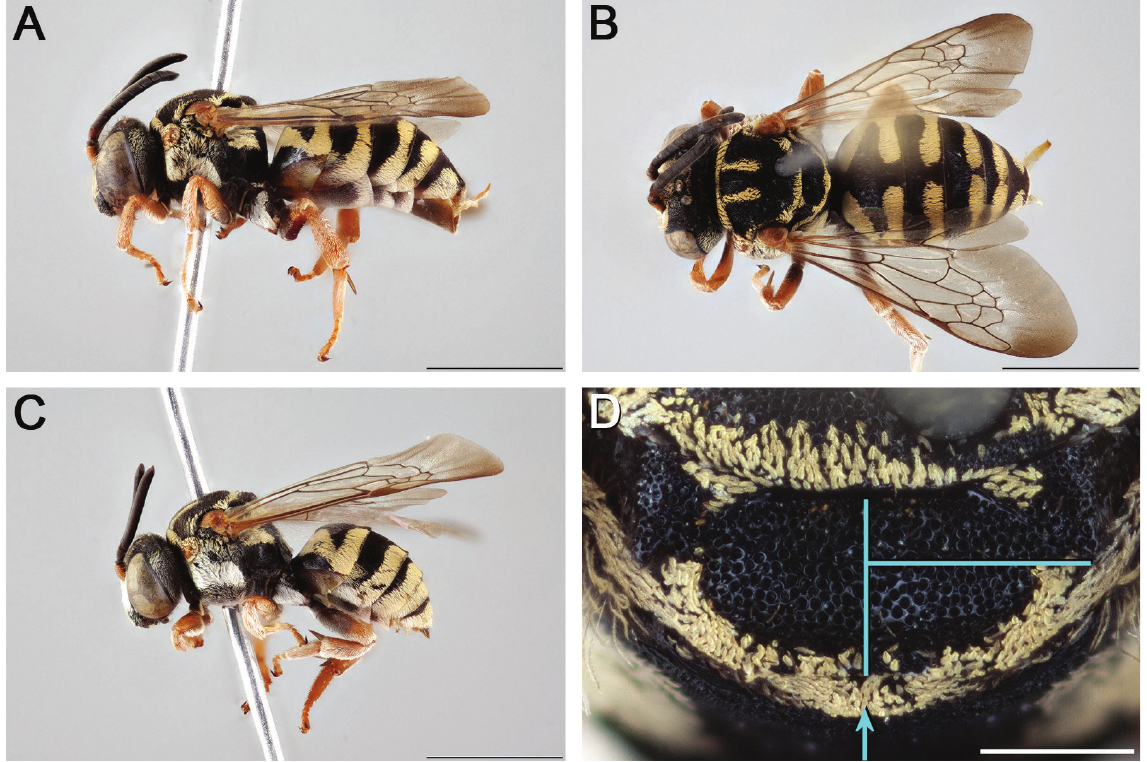
Fig. 13. Epeolus hanusiae sp. nov. A – B , D . Holotype, ♀ (EMEC 1135889). C . Allotype, ♂ (EMEC 1135885). A . Habitus, lateral view. B . Habitus, dorsal view. C . Habitus, lateral view. D . Axillae and mesoscutellum, dorsal view (blue arrow indicates blunt median process of metanotum; blue lines indicate the posterior extent of the axilla relative to the length of the mesoscutellum). Scale bars: A–C = 3 mm; D = 0.5